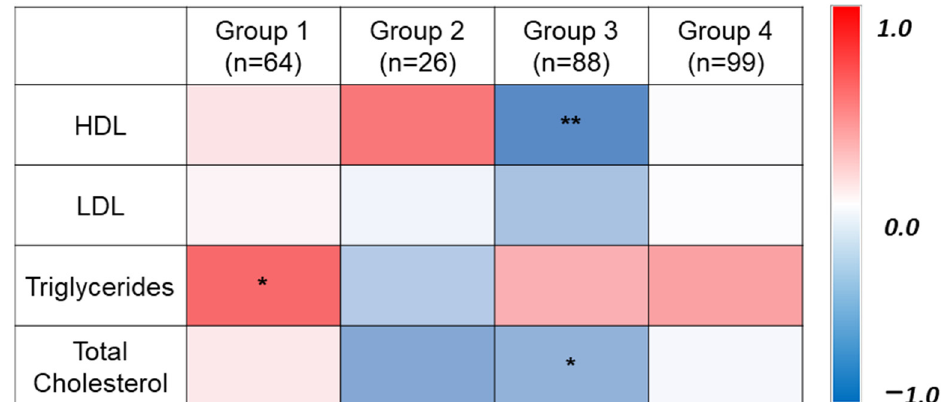
Figure 1. The heat map illustrates Pearson correlation depicting the association between lipid profile components (HDL, LDL, Triglycerides, and Total cholesterol) and serum 25(OH)D among four groups. * p ≤ 0.05, ** p ≤ 0.01. Group 1 (Vitamin D sufficient and normolipidemic); Group 2 (Vitamin D sufficient and dyslipidemia); Group 3 (Vitamin D deficient and dyslipidemia); Group 4 (Vitamin D deficient and normolipidemic).